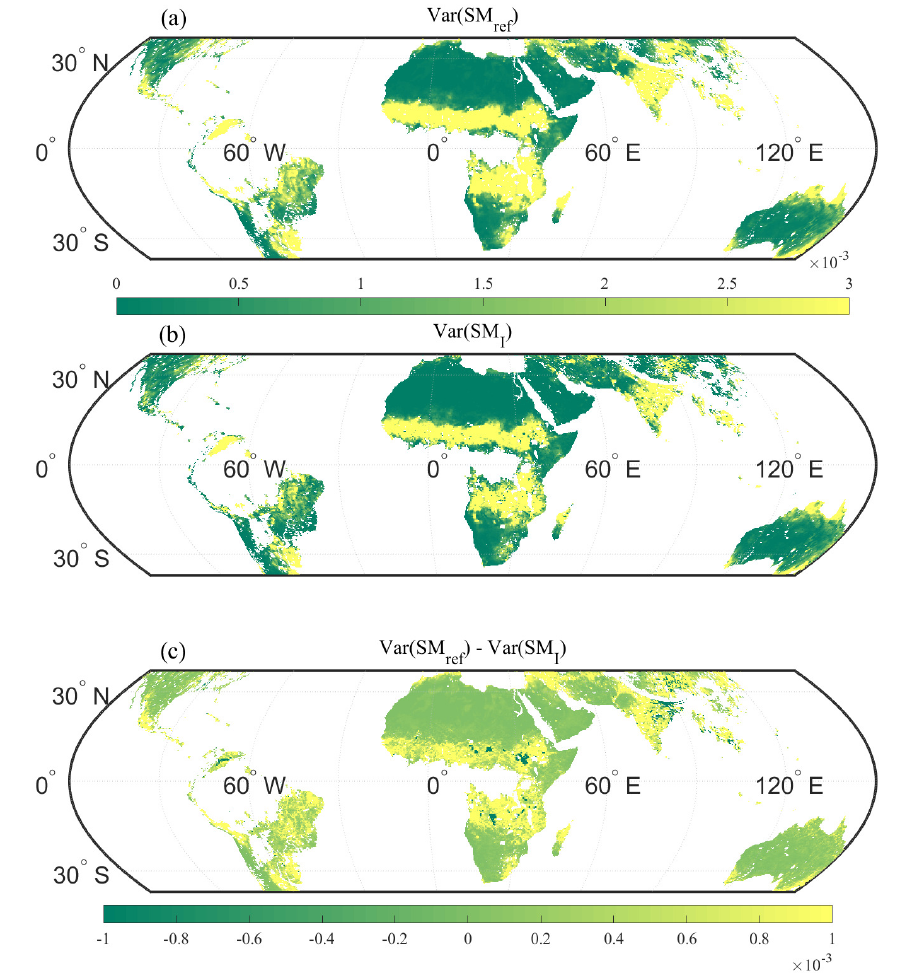
Figure 10. Variance of SMs for: ( a ) reference, ( b ) retrieved from CyGNSS Scheme I data, and ( c ) their